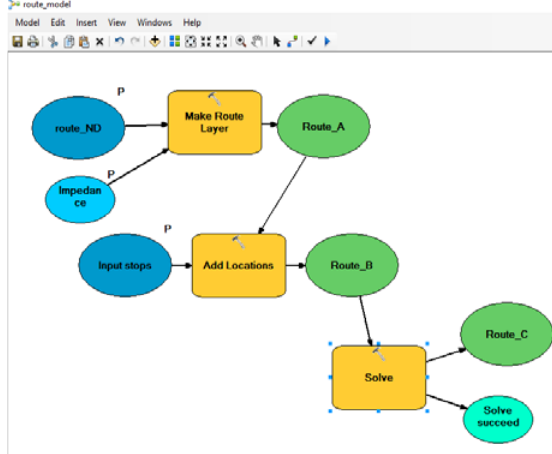
Figure 8. Solve tool